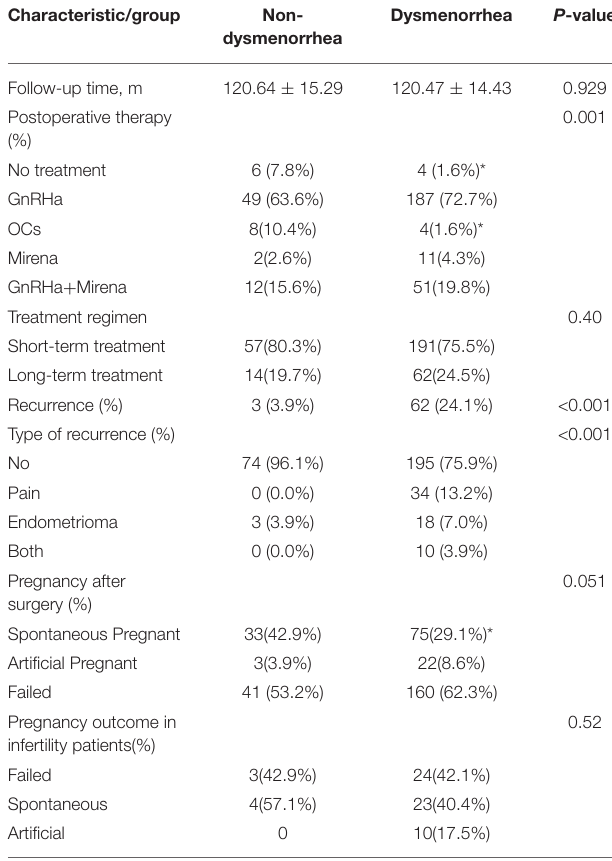
TABLE 4 | Postoperative